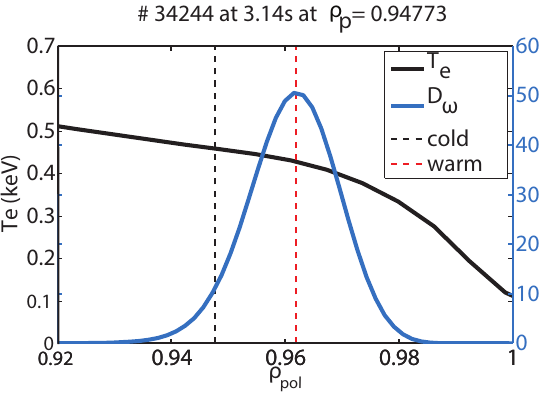
Figure 1. #34244 at t = 3 . 14s: Midplane edge channel with frequency f = 110.4GHz of the ECE-I diagnostic. The cold res- onance position at ρ pol = 0.947, is determined by the magnetic field strength, and is shown as black dashed line. A birthplace distribution of the observed intensity ( D ω ) is shown in blue. The peak of the D ω represents a warm resonance of a channel. The T e profile is shown in a solid black line.